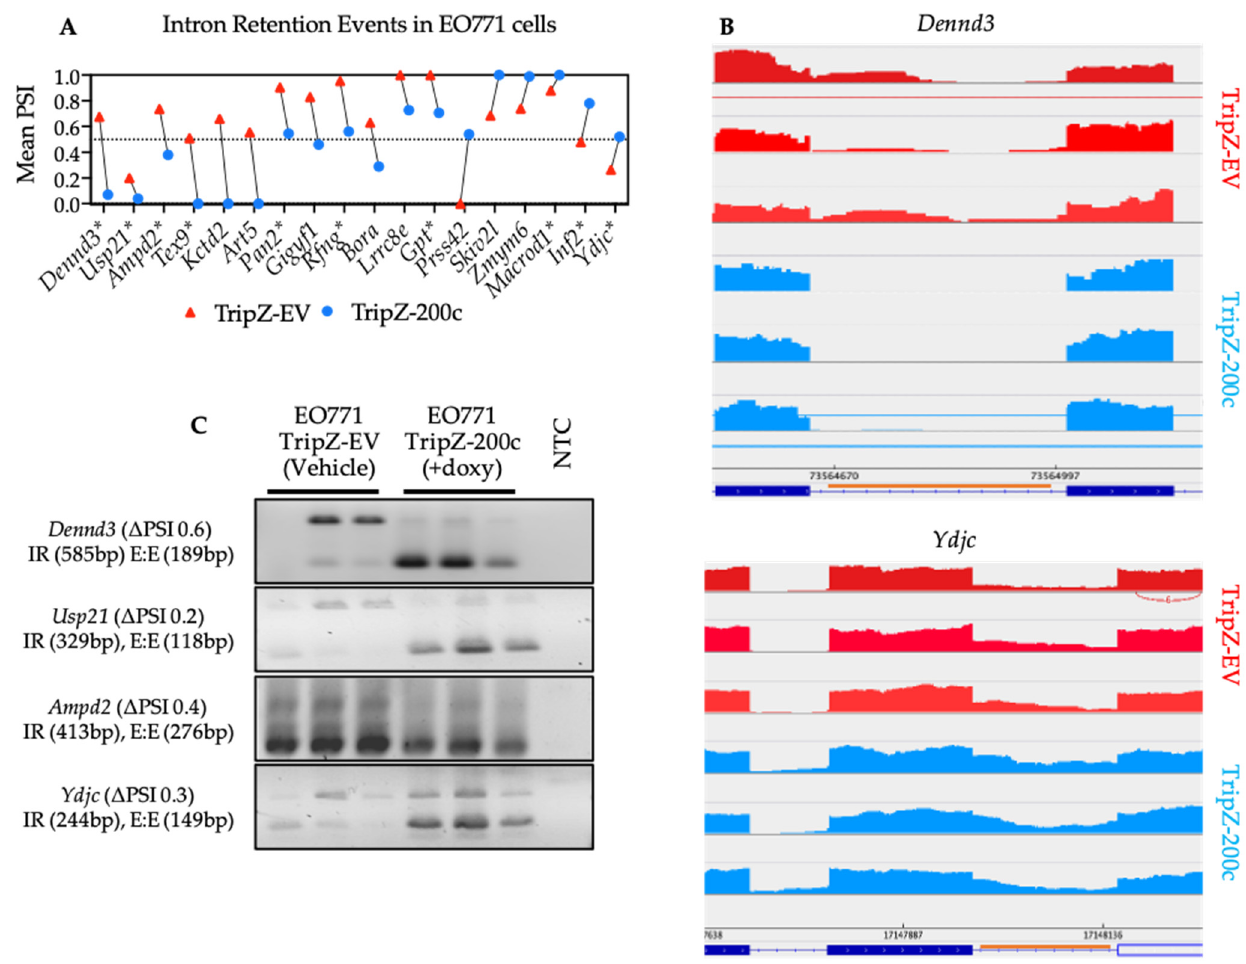
Figure 6. Validation of differentially expressed intron retention events in EO771 cells ± miR-200c. ( A ) Strip plot depicting genes of interest with predicted significant change in mean Percent Spliced In (PSI) of IR events following miR-200c restoration. Genes marked with asterisks (*) showed that splicing events with the Integrative Genomics Viewer (IGV). ( B ) Representative sashimi plots generated using IGV software. The splicing graph depicts the retained intron (orange line) between its flanking exons. ( C ) Representative images of RT-PCR validation of cDNA depicting intron retention events in EO771 cells following miR-200c restoration. When two bands are present, the larger bands correspond to the variant with the retention (IR), whereas the smaller band corresponds to the variant with the normal exon-exon junction (E:E). Table 2. Intron retention-derived peptides and predicted MHC class I binding affinities selected for CD8 + T cell immunogenicity assays.